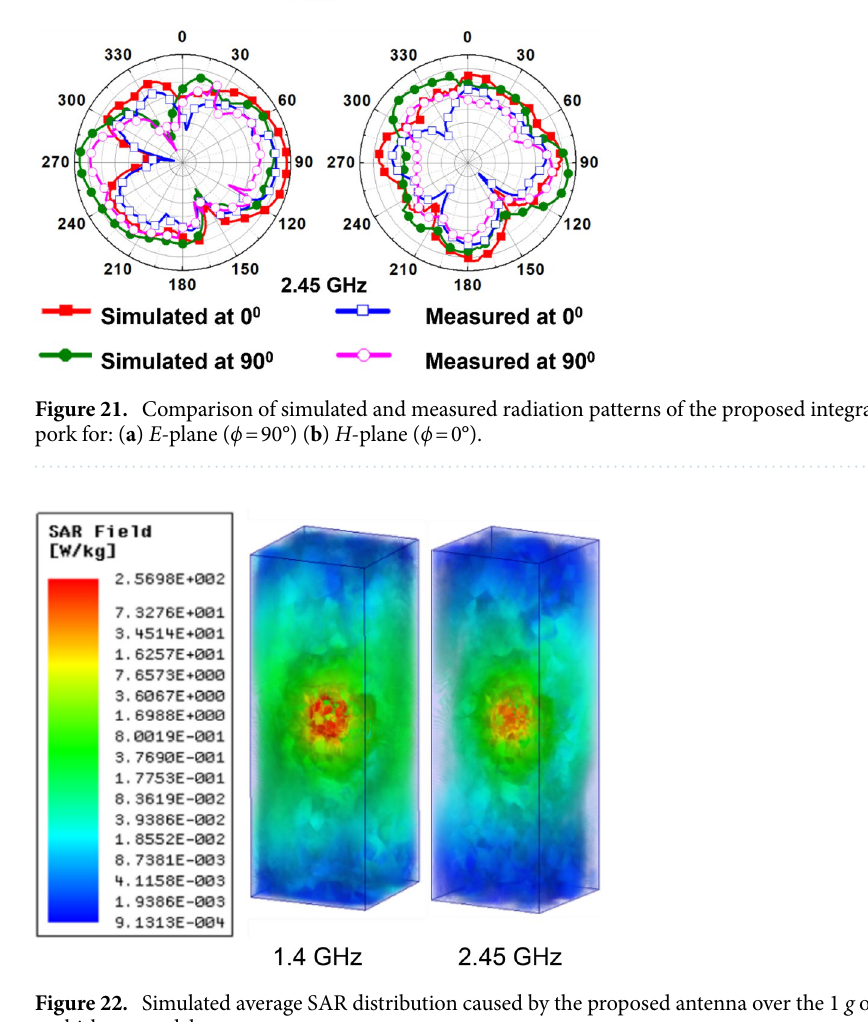
Figure 22. Simulated average SAR distribution caused by the proposed antenna over the 1 g of tissue of heart’s multi-layer